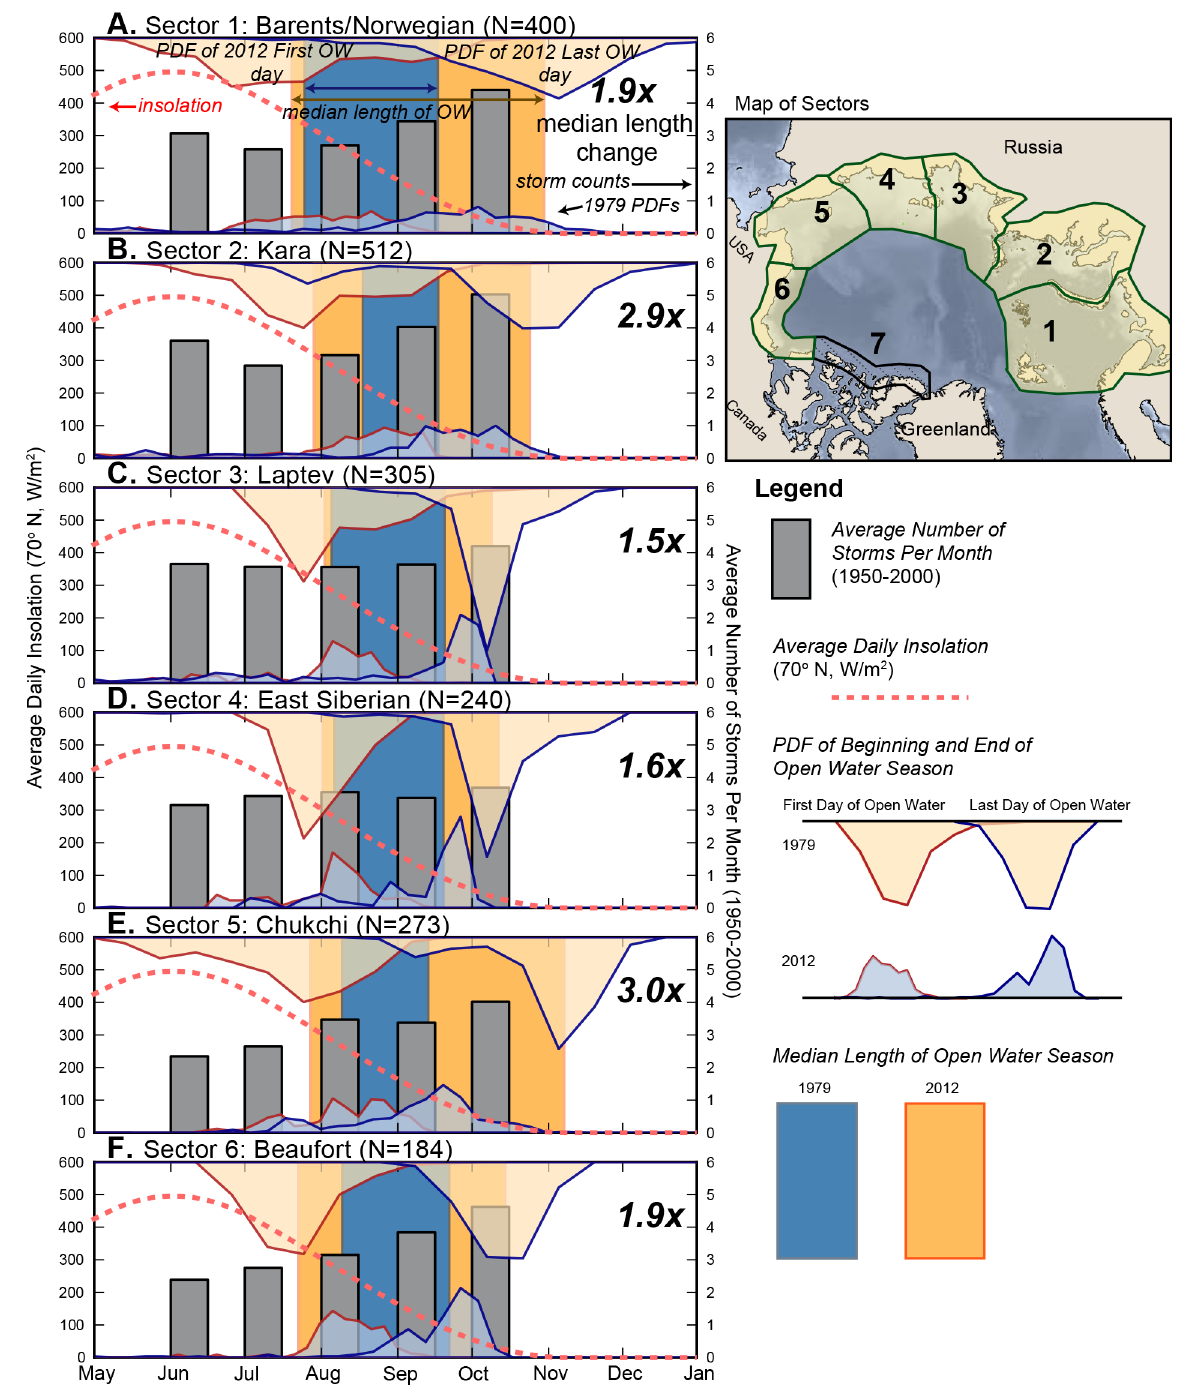
Figure 16. Changes in the length of the open-water season from 1979–2012 by sector (panels on left side). Blue shaded (1979) and yellow shaded (2012) regions show the probability density function of the first day of open water (red outline) and the last day of open water (blue outline). The median length of the open-water season is shown in the figure background. We show the average daily insolation at 70 ◦ north and the average number of storms per month (for the period 1950–2000, from Atkinson, 2005). In many sectors, the fall is stormiest; thus, expansion of the open-water season into the fall allows for additional impact from storms. Expansion of the open-water season into the spring allows for more time at higher insolation levels and thus warmer water